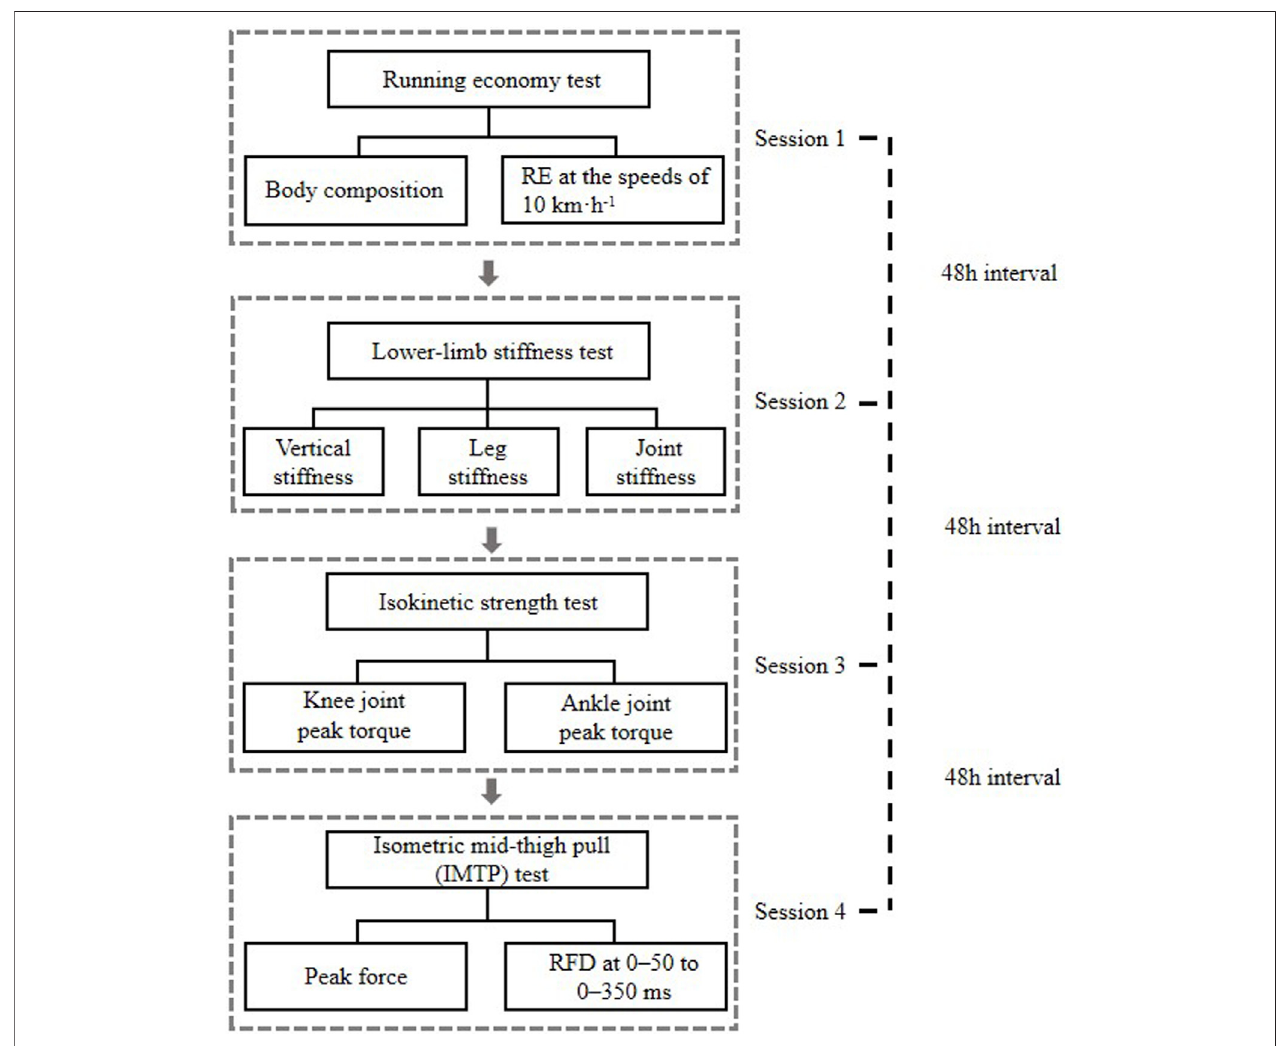
FIGURE 1 | Tests fl ow diagram. RE, running economy; RFD, rate of force development; IMTP, isometric mid-thigh pull.